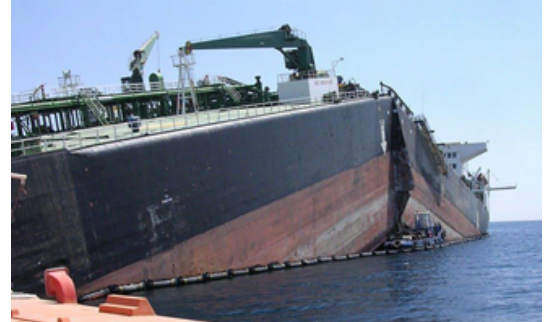
Figure 2: Failure of a ship’s